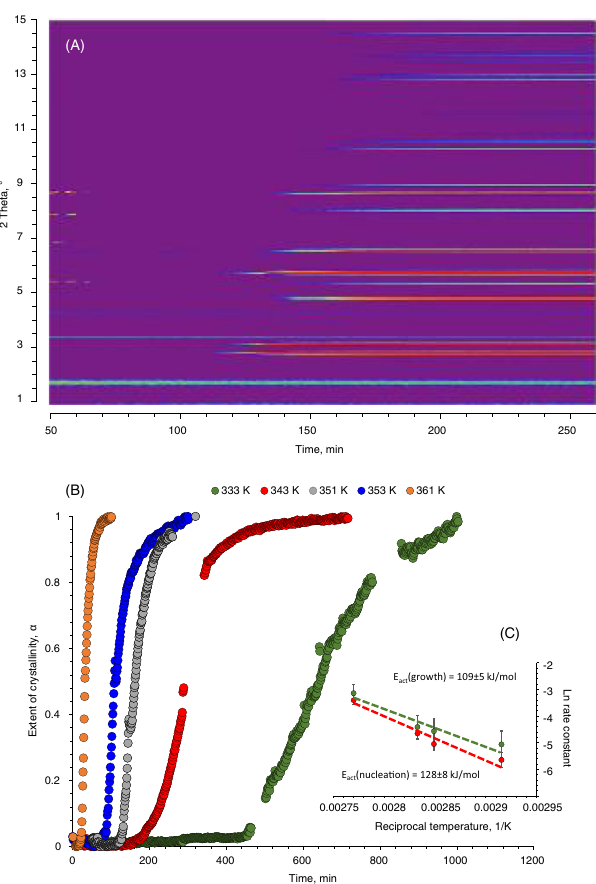
Fig. 4 Time-resolved X-ray diffraction data. ( A ) Time-resolved counterplots of XRD data recorded during the synthesis of MIL-53 at 351 K; ( B ) the excess of MIL-53 crystallinity obtained from the background corrected XRD data together with the corresponding fi ts using Gualtieri model; ( C ) Arrhenius plots for k g and k n formation of formate fi nishes after the complete crystallization of MIL-53, as evidenced by 27 Al MAS NMR spectra (Fig. 3F).